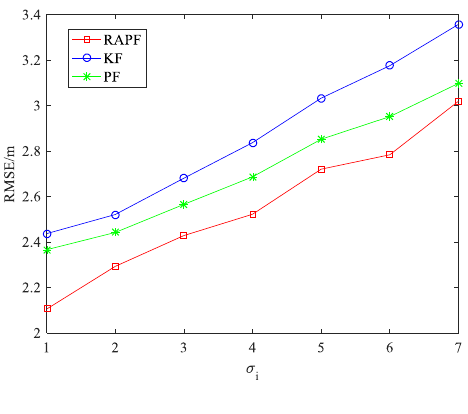
Figure 14. The RMSE versus σ i .